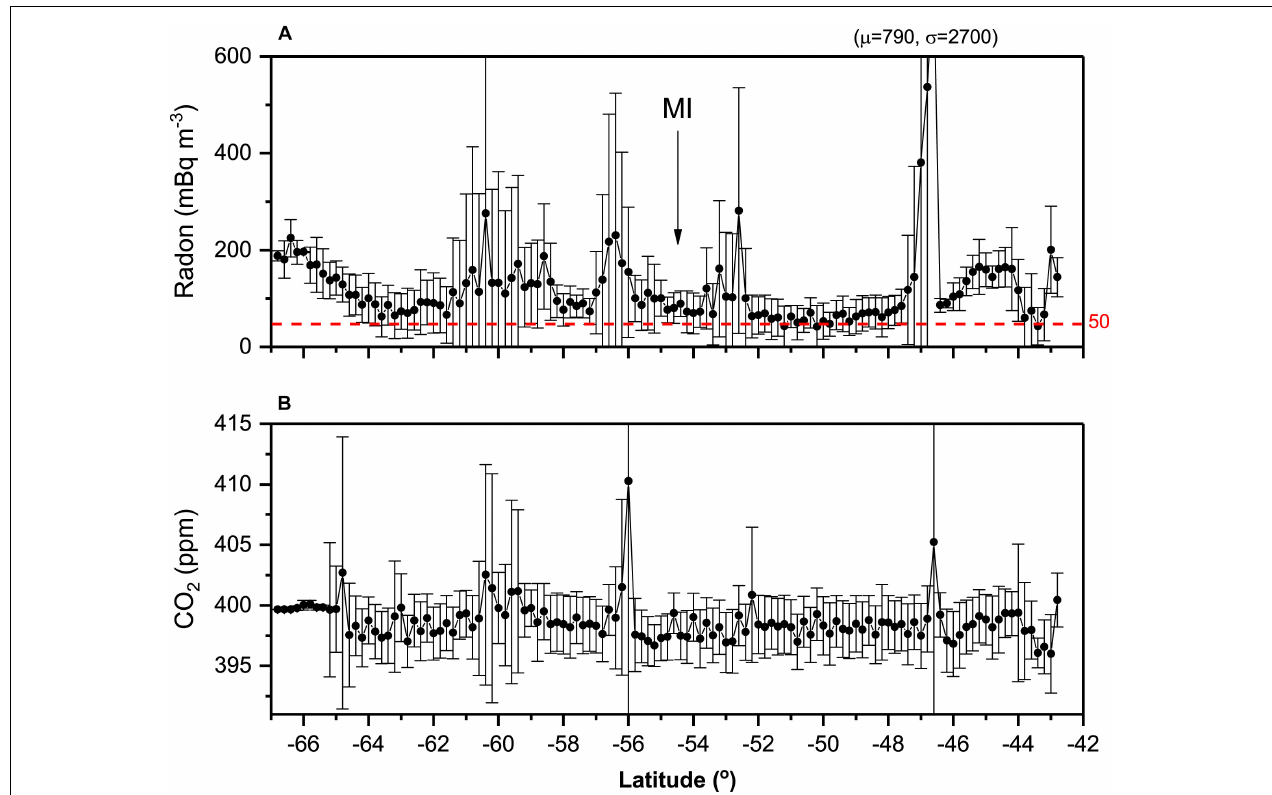
FIGURE 2 | 5-track composite of (A) radon, and (B) carbon dioxide, concentrations (0.2 ◦ latitude bin means) between 45 and 67 ◦ S of Southern Ocean MBL. Whiskers represent ± 1 σ . Approximate location of Macquarie Island is marked.